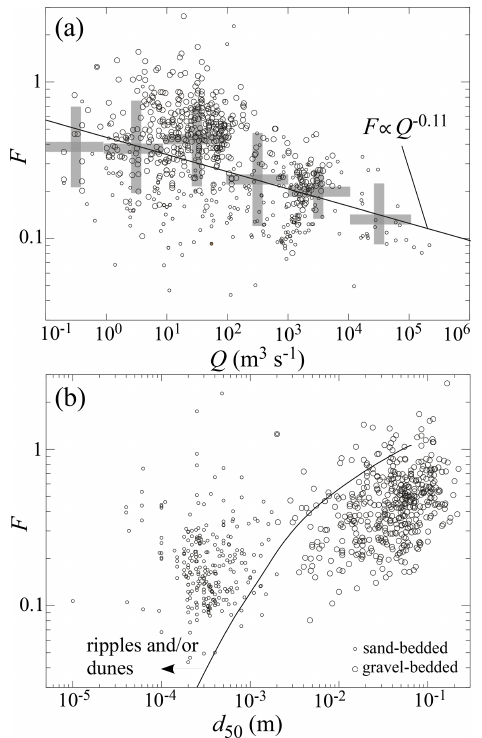
Figure 3. Bank-full Froude number relationships with bank-full discharge and median bed grain diameter. Plot of bank-full Froude number, F , as a function of (a) bank-full discharge, Q , and (b) me- dian grain size, d 50 , for the Dunne and Jerolmack (2018) global dataset. Small circles correspond to sand-bedded channels ( d 50 < 2mm), and large circles correspond to gravel-bedded channels ( d 50 > 2mm). The curve in (b) defining channels that likely have ripples and/or dunes is based on the subset of 3791 field studies and experiments compiled by Ohata et al. (2017) and graphed in Fig.